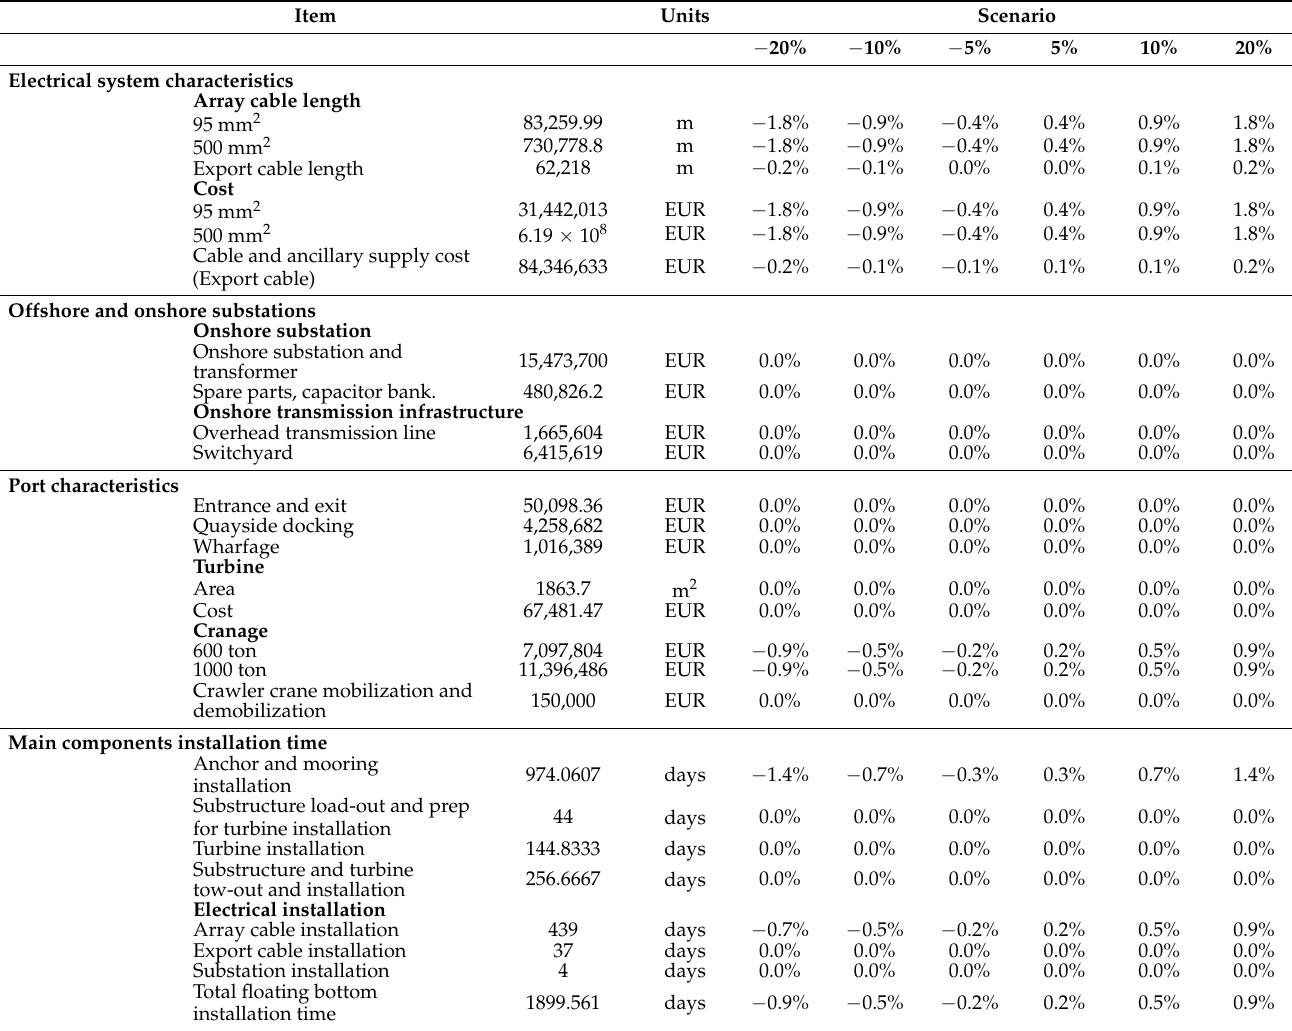
Table A2. Variability associated with the water